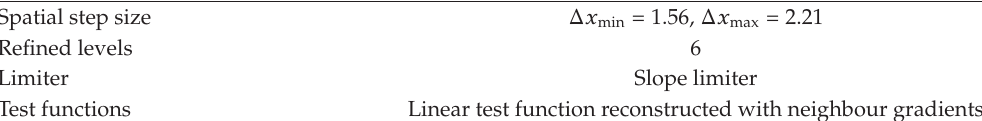
Table 9: Spatial discretization parameters.